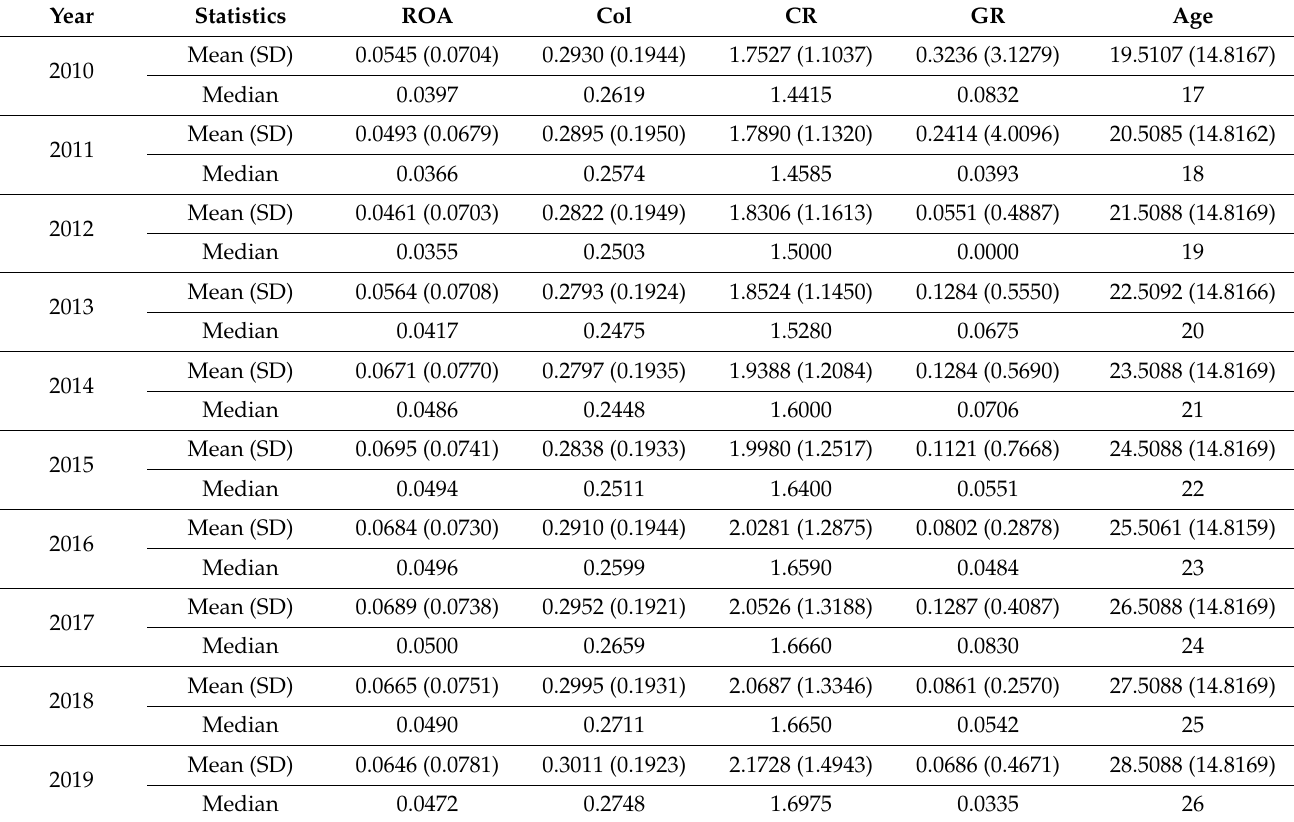
Figure 1. 95% confidence intervals for mean values of trade and bank credit by year. Table 1. Descriptive statistics.